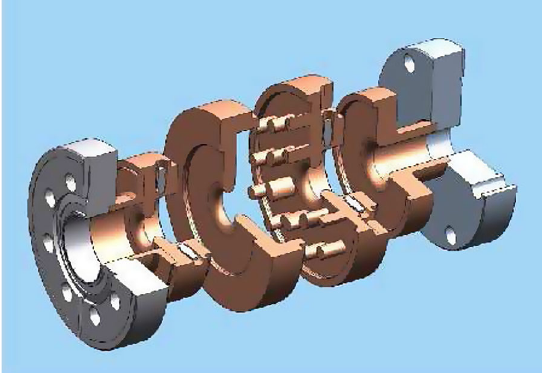
FIG. 1. Expanded three-quarter view of solid model of elliptical-rod PBG structure, showing two coupling cells and central PBG cell. Power is coupled in from the